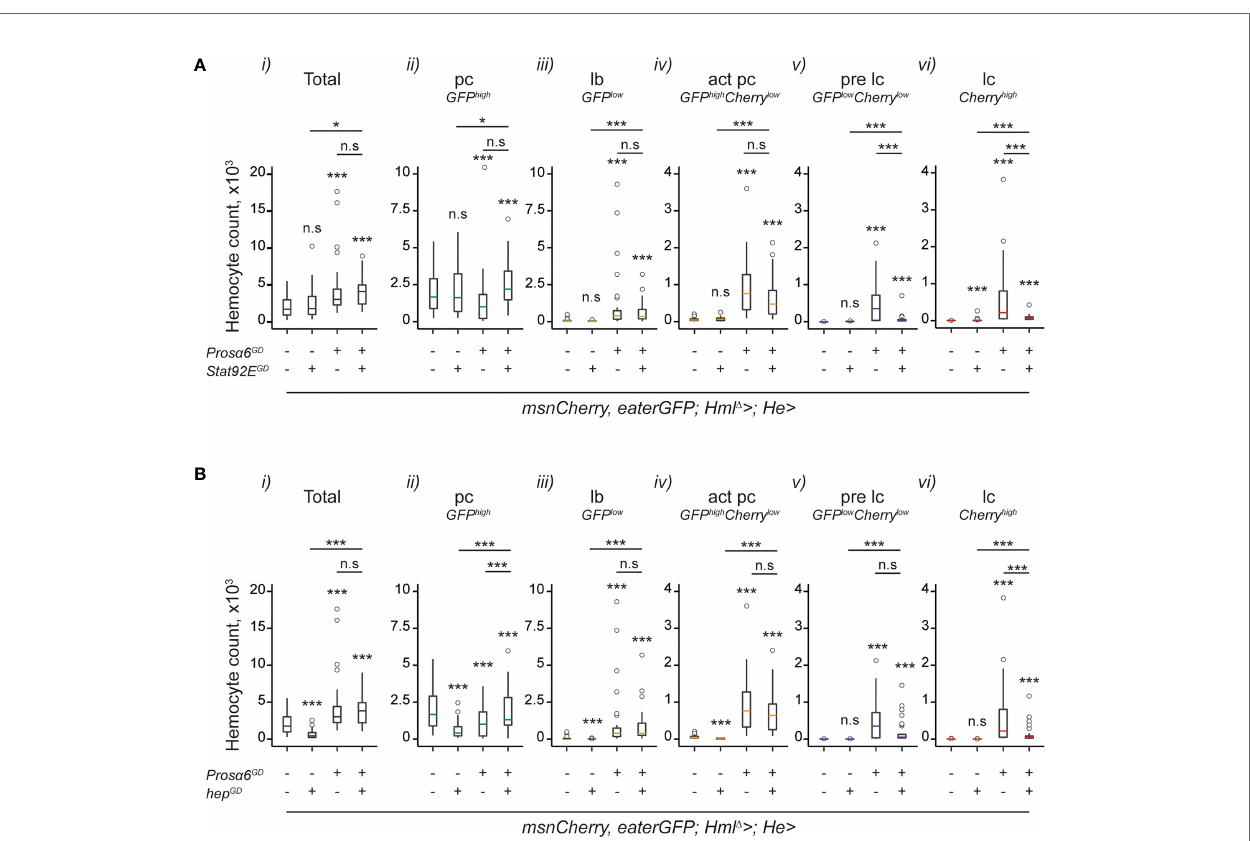
FIGURE 5 | Knocking down JAK/STAT and JNK pathway components in the Pros a 6 background reduce the hemocyte activation caused by the Pros a 6 silencing. (A) Effects of JAK/STAT pathway component Stat92E knockdown on Pros a 6 -induced hemocyte phenotype. i) Total hemocyte counts. ii-vi ) Differential hemocyte counts. “ -/+ ” indicate the presence of Pros a 6 and Stat92E knockdowns. Stars refer to the statistical difference compared to the wild-type control larvae ( msnCherry, eaterGFP;Hml D -GAL4;He - GAL4/w GD ) , the fi rst sample in each plot. Underlined stars refer to the statistical difference of the simultaneous knockdown of Pros a 6 and Stat92E ( msnCherry,eaterGFP;Hml D -GAL4;He - GAL4/UAS- Pros a 6 GD ;UAS-Stat92E GD ) to the single knockdowns of Pros a 6 (short line) and Stat92E (longer line). (B) Effects of JNK pathway component hep knockdown on Pros a 6 -induced hemocyte phenotype. i) Total hemocyte counts. ii-vi ) Differential hemocyte counts. “ -/+ ” indicate the presence of Pros a 6 and hep knockdowns. Stars refer to the statistical difference compared to the wild-type control larvae ( msnCherry,eaterGFP;Hml D - GAL4;He - GAL4/w GD ), the fi rst sample in each plot. Underlined stars refer to the statistical difference of the simultaneous knockdown of Pros a 6 and hep ( msnCherry, eaterGFP;Hml D -GAL4;He - GAL4/UAS- Pros a 6 GD ;UAS-hep GD ) to the single knockdowns of Pros a 6 (short line) and hep (longer line). Each genotype was replicated three times, except for the msnCherry,eaterGFP;Hml D -GAL4;He - GAL4/w GD control, which was replicated 6 times, 10 animals in each replicate. Note that the control and Pros a 6 hemocyte data is the same in (A, B) and has been plotted separately for clarity. Statistical analyses have been conducted on the whole dataset and p- values adjusted according to multiple comparisons. Data was analyzed using a negative binomial GLM. n.s., not signi fi cant; *p < 0.05; ***p < 0.001; pc, plasmatocyte; act pc, activated plasmatocyte; lb, lamelloblast; pre lc, prelamellocyte;